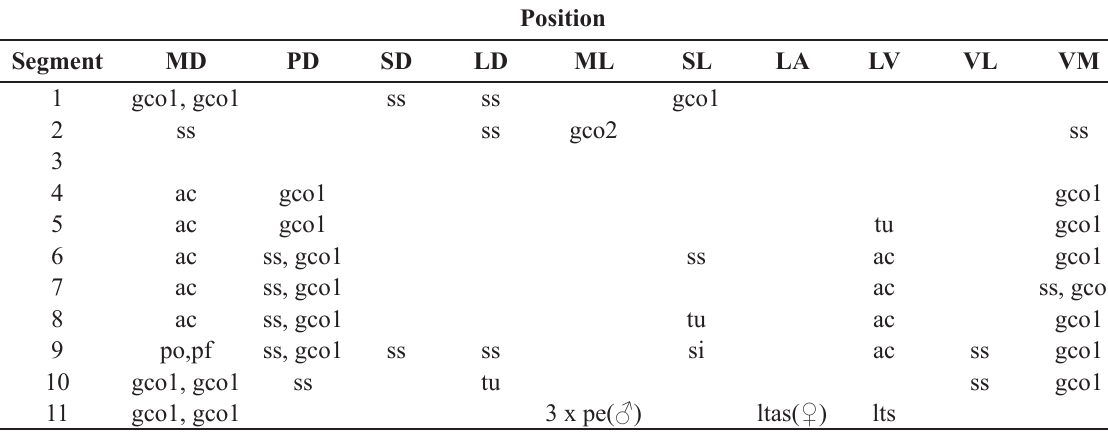
Table 5. Summary of nature and location of sensory spots, glandular cell outlets, tubes and spines arranged by series in Echinoderes dubiosus sp. nov. Abbreviations: LA = lateral accessory; LD = laterodorsal; LV = lateroventral; MD = middorsal; ML = midlateral; PD = paradorsal; SD = subdorsal; SL = sublateral; VL = ventrolateral; VM = ventromedial; ac = acicular spine; gco 1/2 = glandular cell outlet type 1/2; ltas = lateral terminal accessory spine; lts = lateral terminal spine; pe = penile spines; pf = papillary flap; po = pore; si = sieve plate; ss = sensory spot; tu = tube; (♀) = female and ( ♂ ) = male conditions of sexually dimorphic